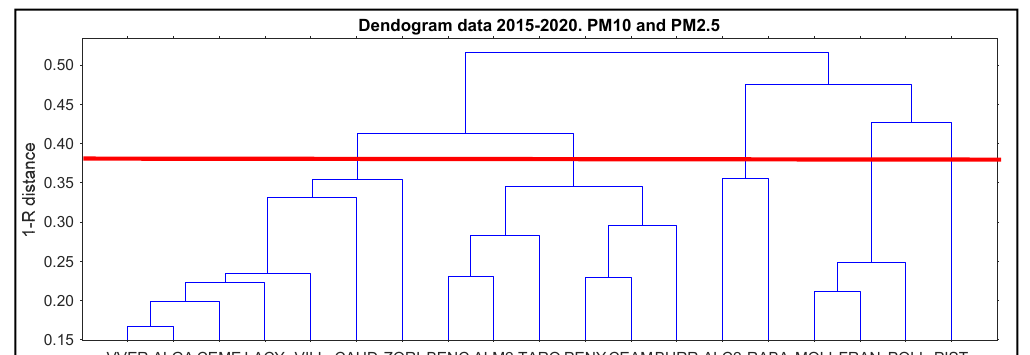
Figure 7. Dendrogram using 1-R (Pearson coefficient) as distance using PM 10 and PM 2.5 concentra- tion data.